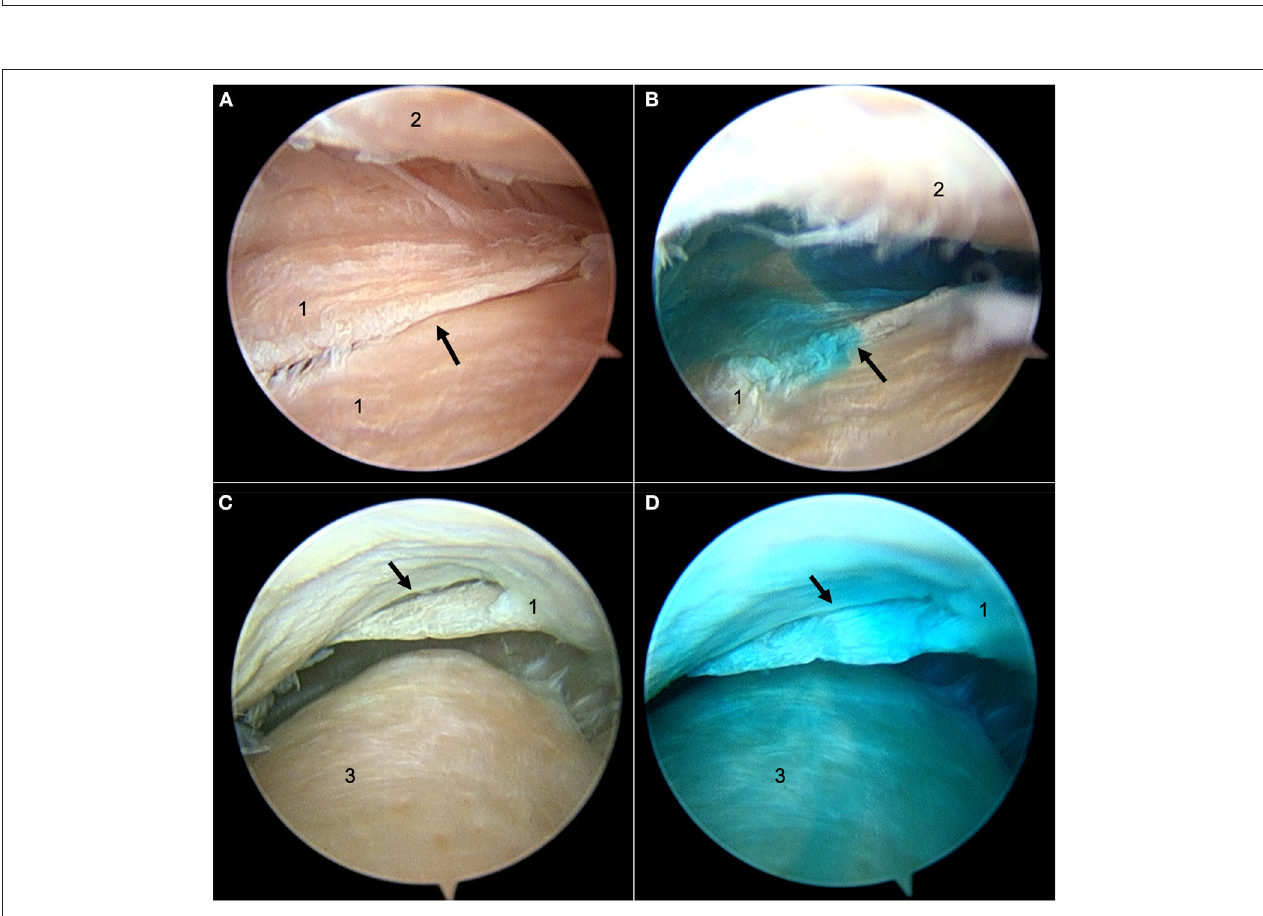
FIGURE 4 | Still arthroscopic images from the left TMJ of the 26-year-old Arabian gelding. (A) The perforation (black arrow) in the intra-articular disc viewed from the discotemporal joint (DTJ) before new methylene blue dye injection. (B) New methylene blue dye passing through the perforation up into the DTJ after being injected into the discomandibular joint (DMJ) below. (C) The perforation (black arrow) viewed from the DMJ before dye injection. (D) Dye in the DMJ after new methylene blue dye injection into the DTJ. 1, intra-articular disc; 2, articular eminence of the temporal bone; 3, mandibular condyle.